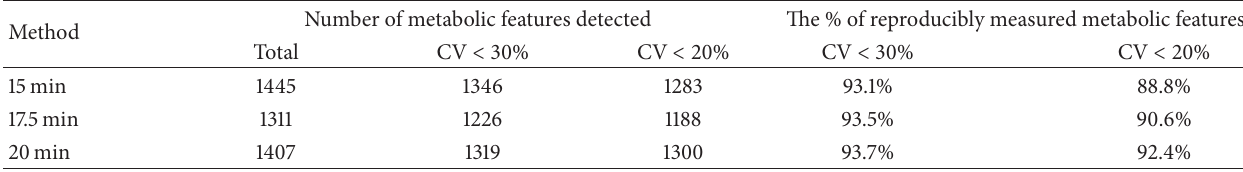
Table 2: The number of metabolic features detected with different slopes of the gradient.